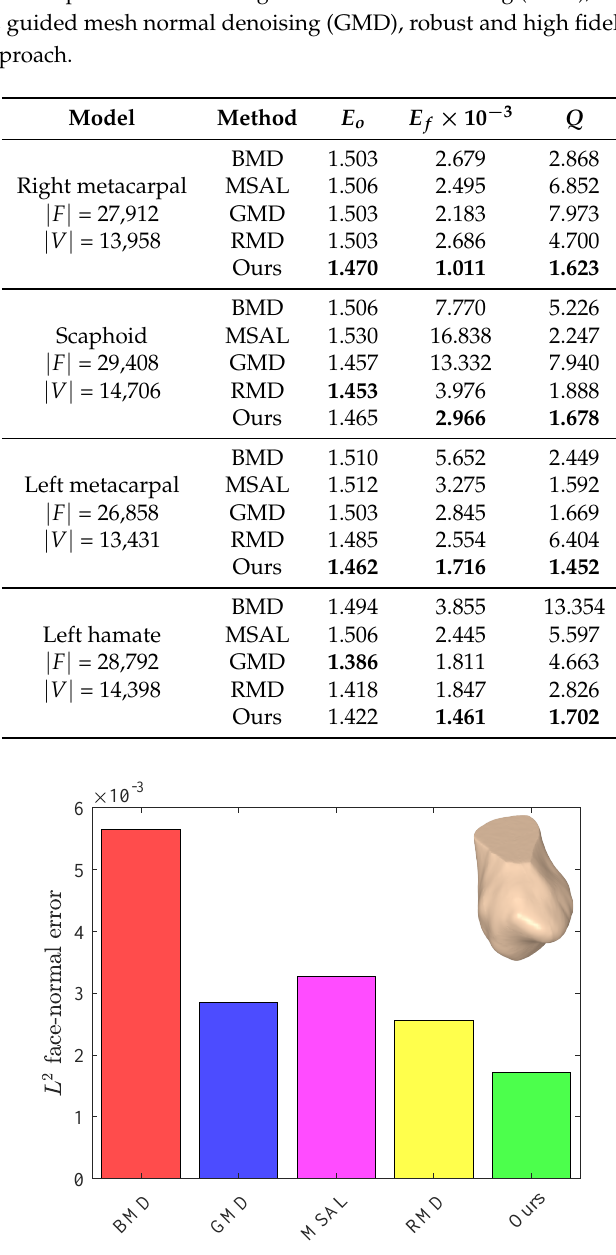
Figure 9. L 2 face-normal errors for the left metacarpal